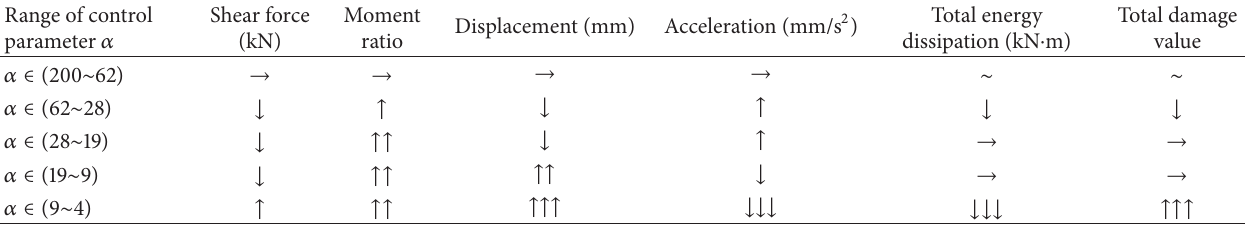
Table 3: Analytical table of the influence of varying stiffness degradation parameter 𝛼 on structural responses and damage. Range of control Shear force parameter 𝛼